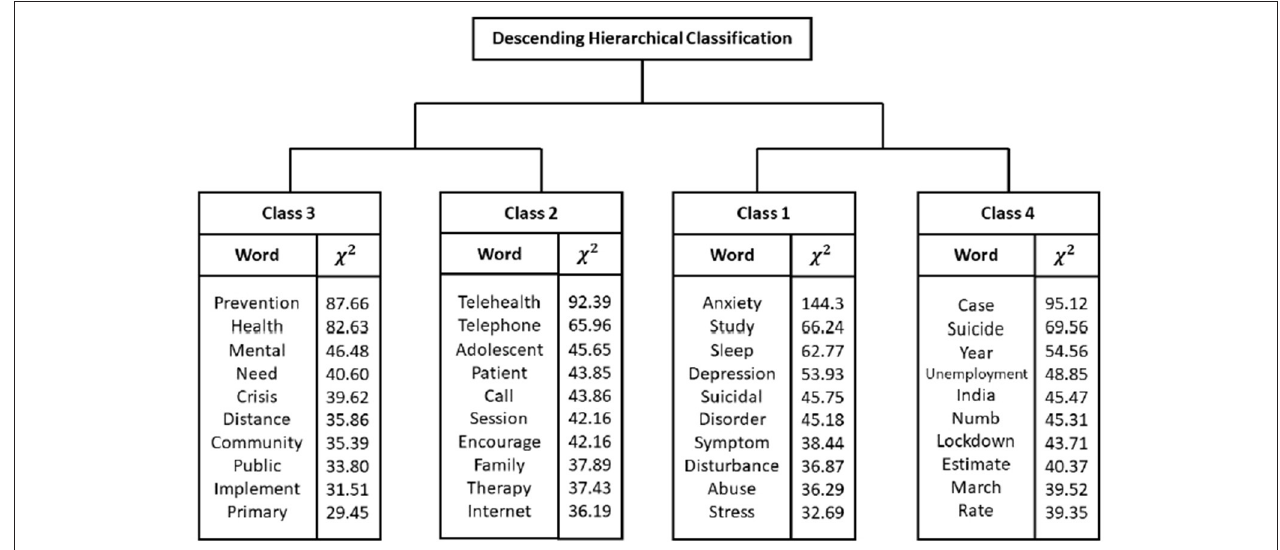
FIGURE 1 | Descending hierarchical classification (dendrogram) with most frequently words and chi-square